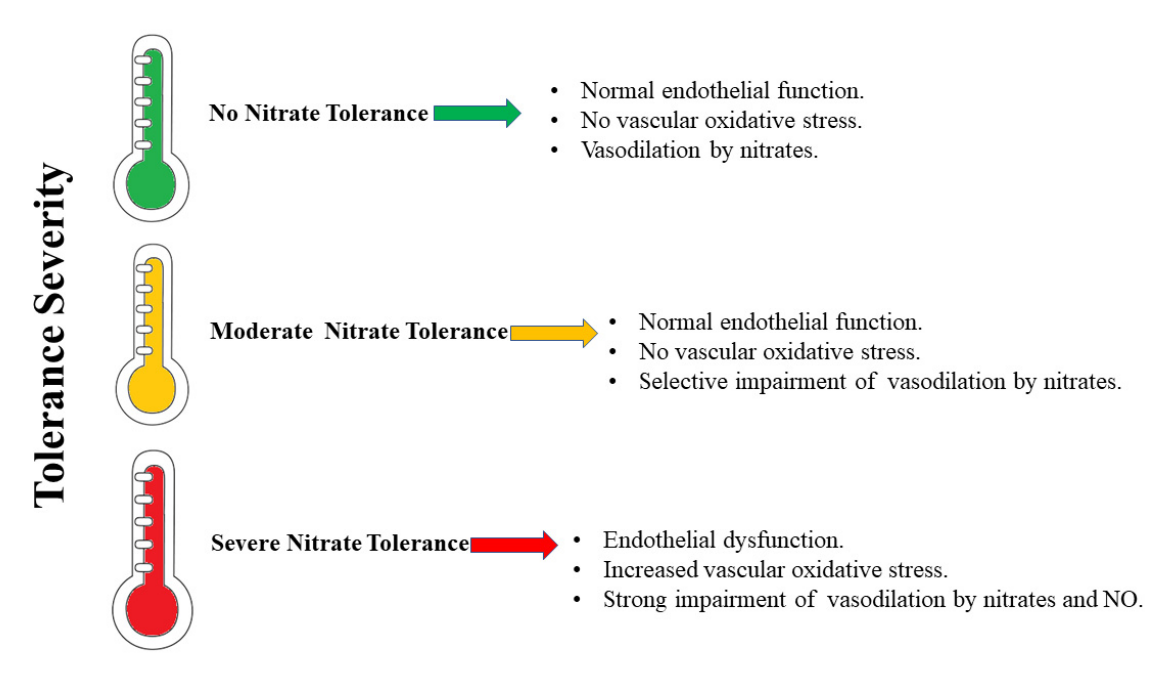
Figure 2. The severity of nitrate tolerance and its effects.